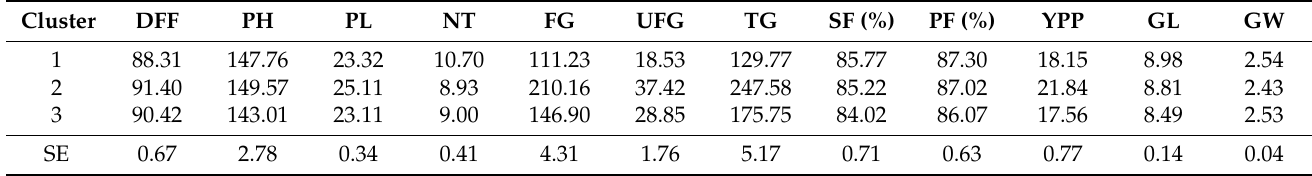
Table 3. Cluster centroids for different agro-morphological traits.